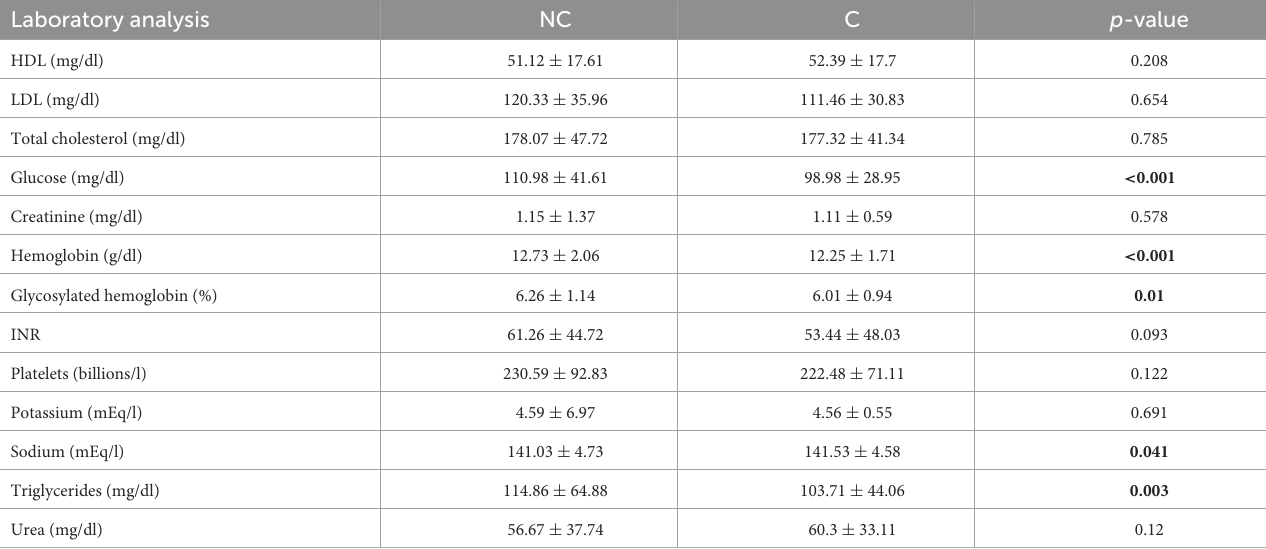
TABLE 6 Laboratory analyses results for centenarians and non-centenarians. Mean ±